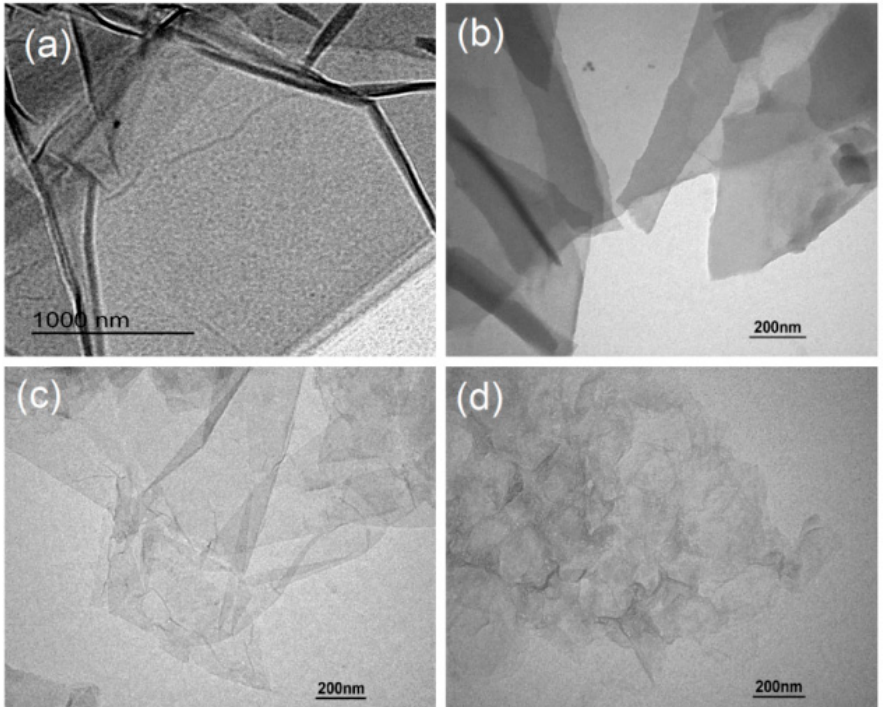
Figure 3. TEM images of GO nanosheets from ( a ) original GO suspension; ( b ) GO/PAM intercalation composites; ( c ) GO/PAH intercalation composites; and ( d ) GO/PAA intercalation composites.